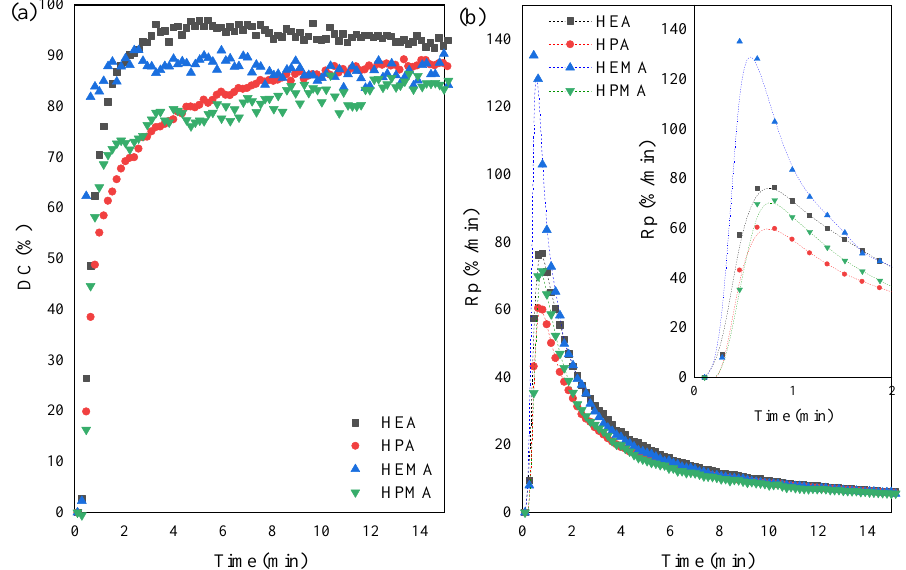
Figure 6. Photopolymerization process of obtained UA-DA resins monitored by FTIR; ( a )—conversion degree, and ( b )—photopolymerization rate during UV exposure.